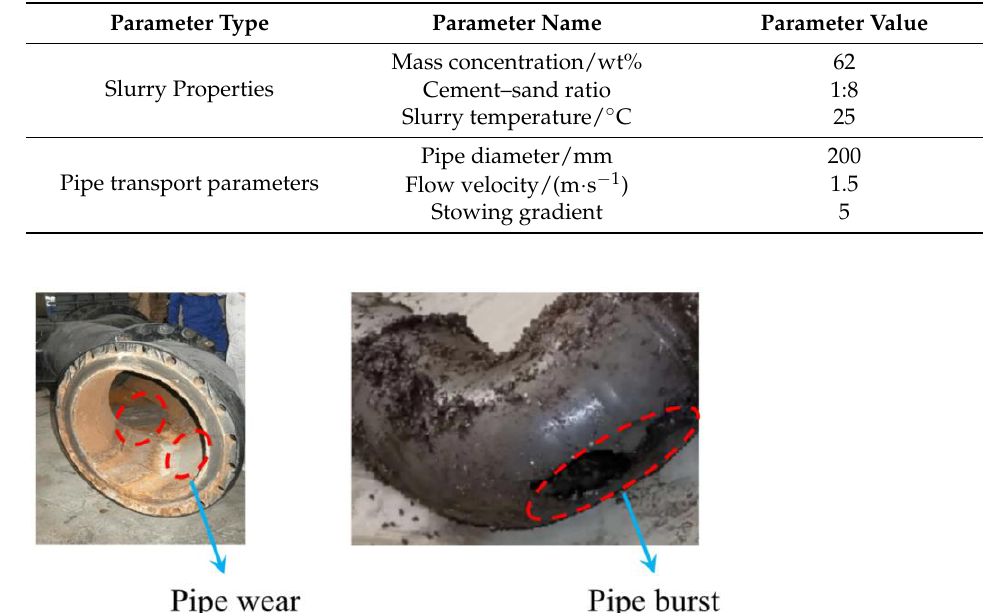
Table 1. Mine filling parameters.